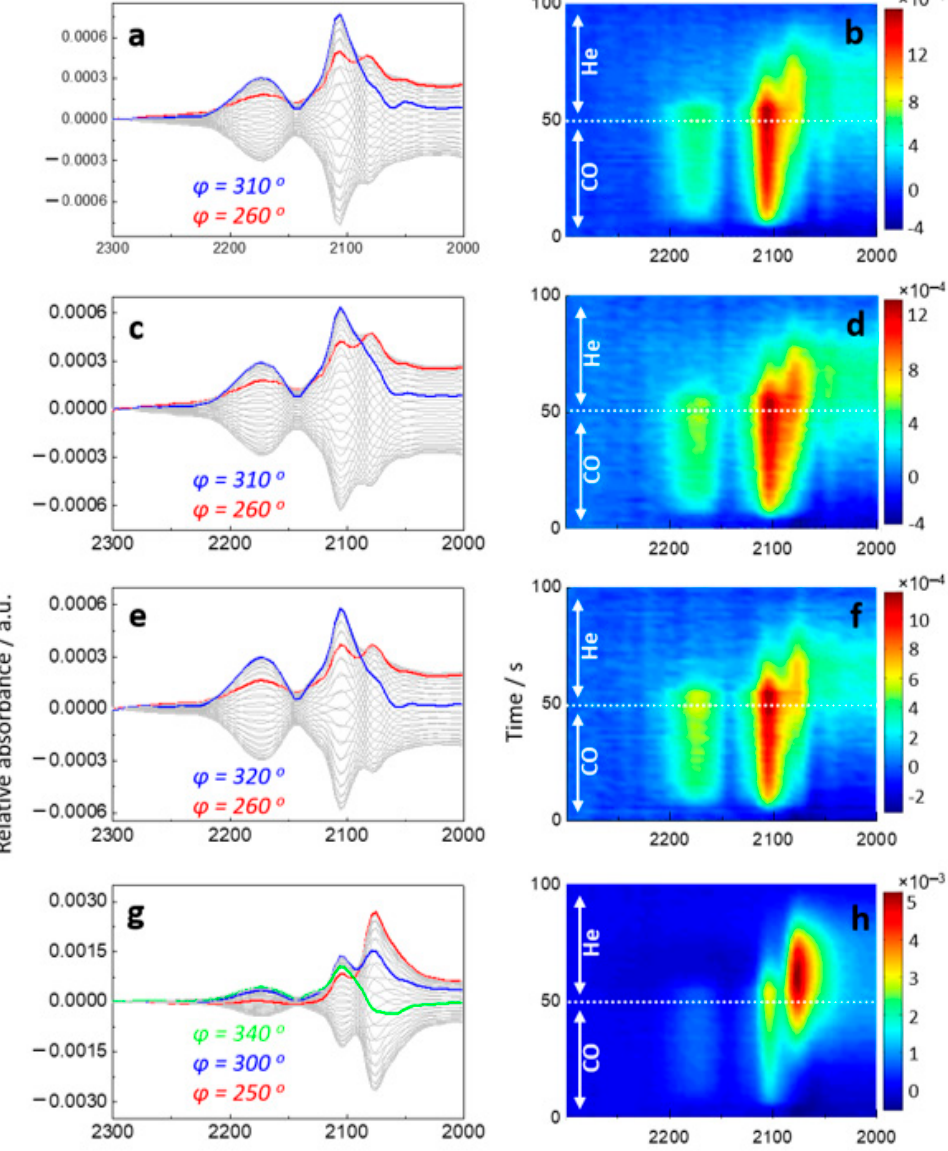
Figure 5. ( a , c , e , g ) Phase-domain and ( b , d , f , h ) time-domain DRIFTS spectra during CO adsorption and desorption on ( a , b ) AuPd/TiO 2 , ( c , d ) AuPd-La(2:1)/TiO 2 , ( e , f ) AuPd-La(1:1)/TiO 2 , and ( g , h ) AuPd-La(1:2)/TiO 2 at 50 ◦